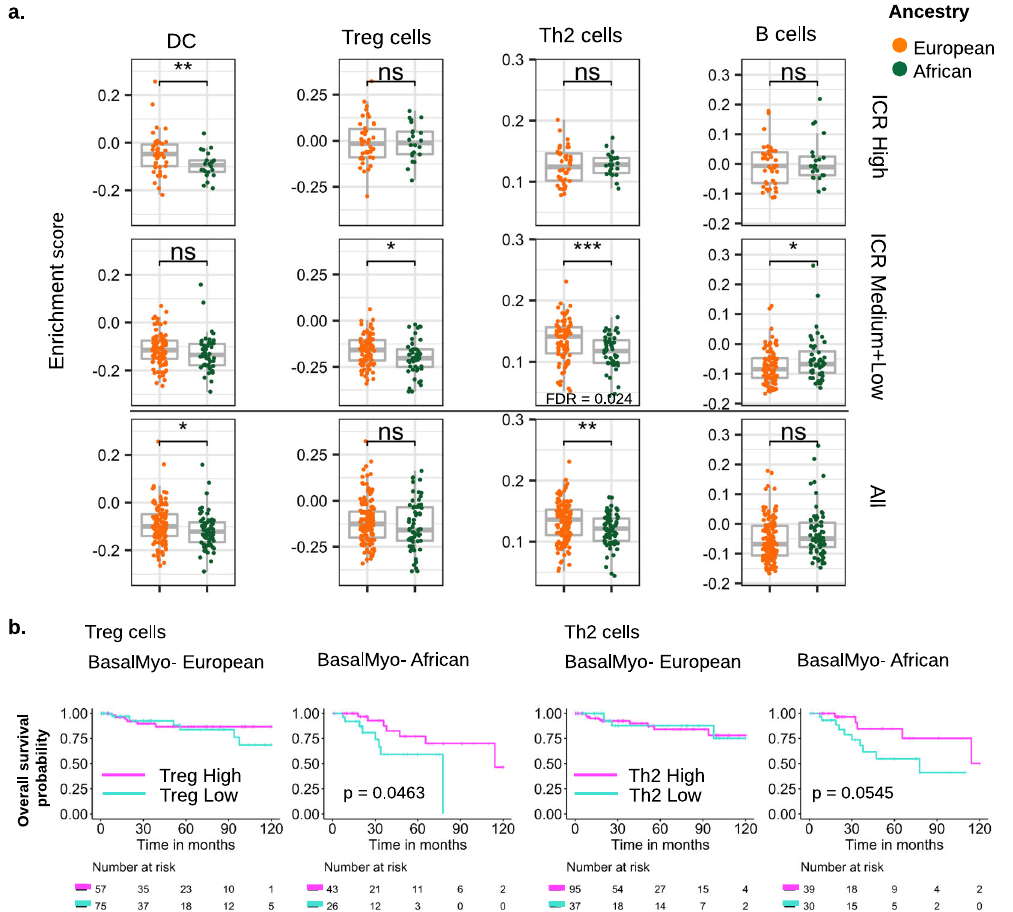
Fig. 3 Enrichment of immune cell subpopulations in AA and EA patients with BasalMyo breast tumors. a . Enrichment scores of signatures re fl ecting the abundance of dendritic cells (DCs), T-regulatory cells (Tregs), T-helper 2 (Th2), and B cells in BasalMyo tumor samples of EA and AA patients. Box plots are facetted by ICR groups, ICR high (upper panels), ICR medium + low (middle panels), and across all samples (lower panels). Box plots indicate medians and interquartile range, and whiskers represent 10th and 90th percentile. All data points are plotted individually. T test (two-sided): * p < 0.05, ** p < 0.01, *** p < 0.001, and n.s. not signi fi cant. Adjusted p value (FDR) by Benjamini and Hochberg method. b Kaplan – Meier plots of overall survival in EA and AA patients with BasalMyo breast cancer dichotomized by enrichment scores of TReg (left panels) and Th2 cell signatures (right panels). Cutoff for dichotomization in “ High ” and “ Low ” categories is based on optimal enrichment cutoff determined by XGBoost model used for survival analysis. Censor points are indicated by vertical